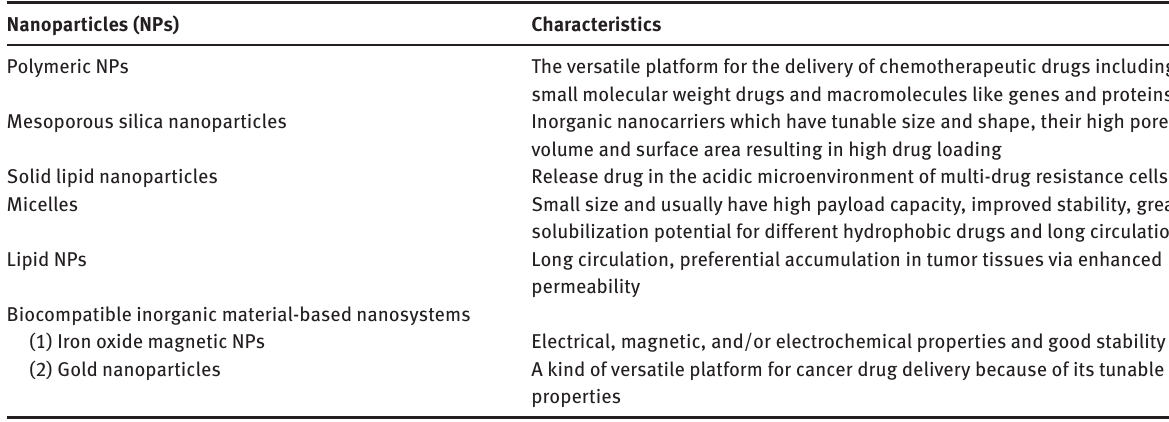
Table 1: Characteristics of nanoparticle systems. Nanoparticles